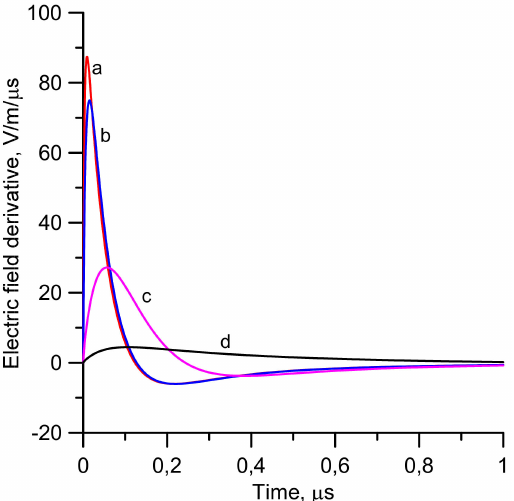
Figure 10. Derivative of the source electric field at 100 km for several electrical parameters of the strike point. ( a ) Sea water: σ = 5 S/m, ε r = 80 and ( b ) σ = 0.01 S/m, ε r = 10, ( c ) σ = 0.001 S/m, ε r = 10, and ( d ) σ = 0.0001 S/m, ε r =